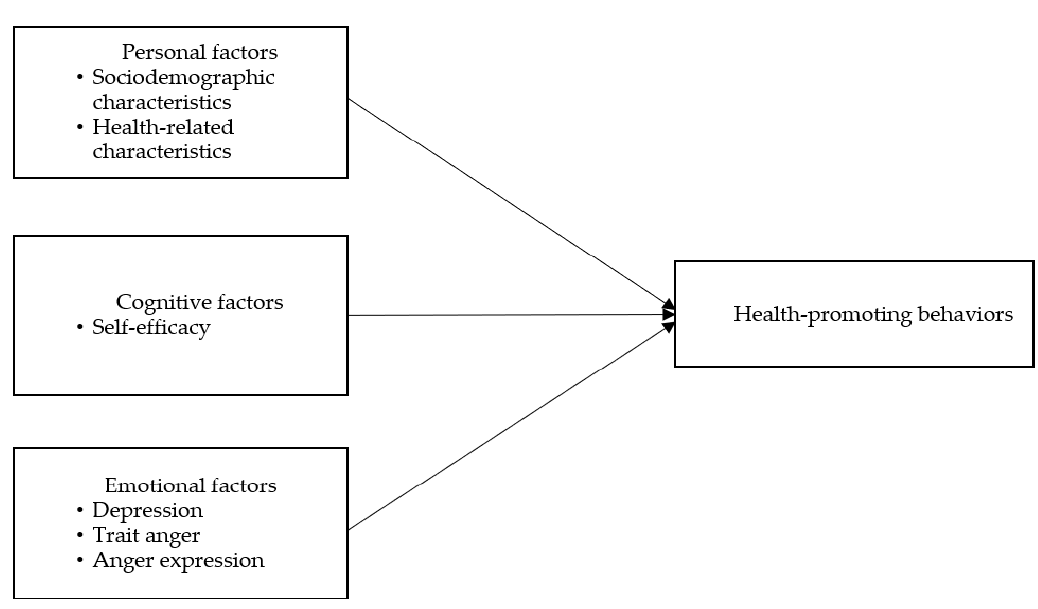
Figure 1. The conceptual framework.